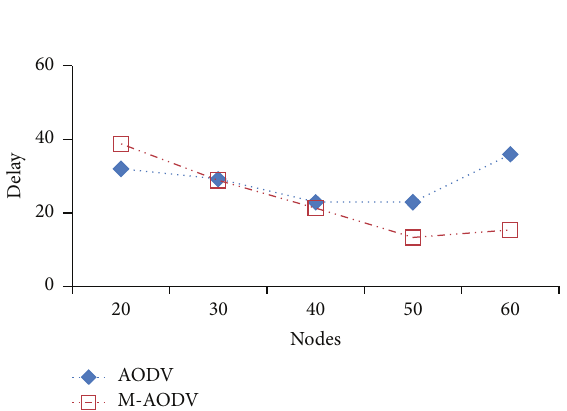
Figure 8: Delay under wormhole attack.